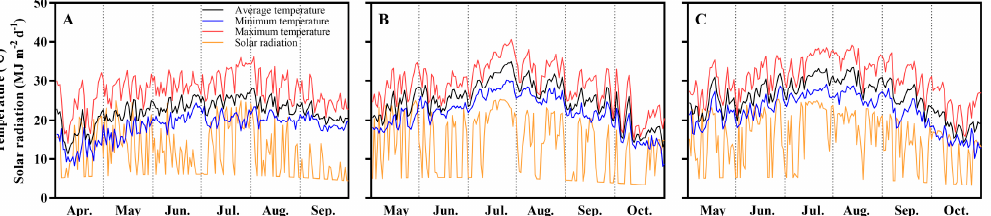
Figure 1. The daily average, minimum, and maximum temperatures and solar radiation during the whole rice growth season in 2015 at Xindu ( A ), and in 2017 ( B ) and 2018 ( C ) at